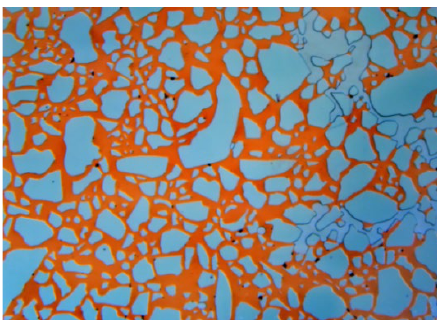
Figure 3. Gas injection process.